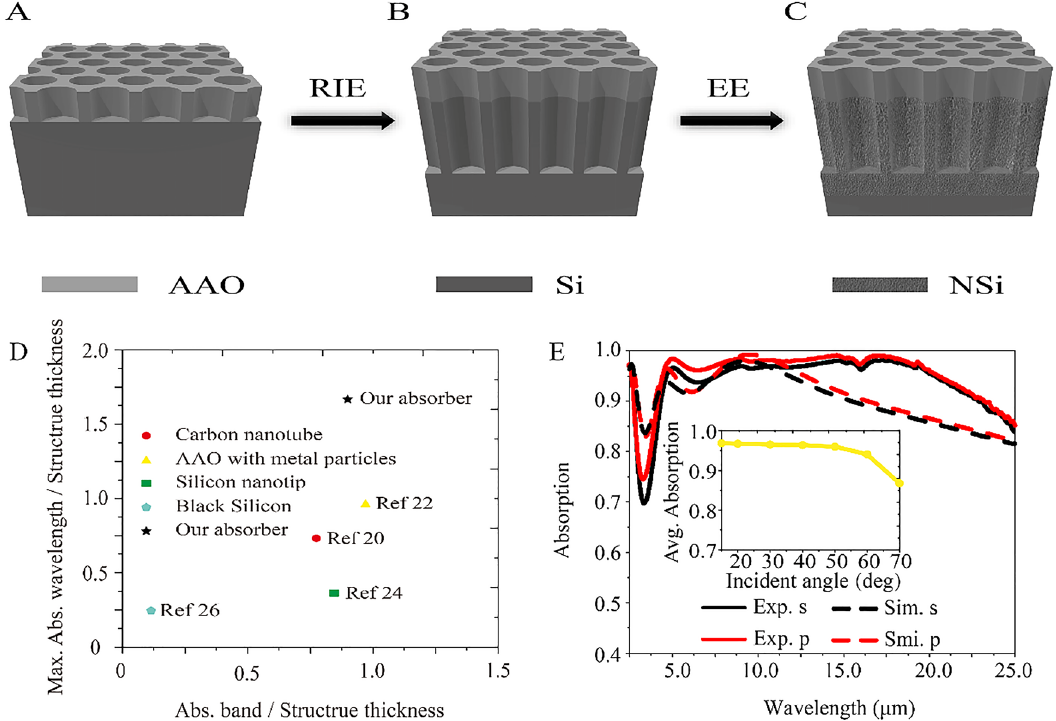
Figure 1: (A – C) Schematic of the fabrication process. (A) Si substrate covered with mesoporous honeycomb AAO layer. (B) AAO/SH/Si structure formed after RIE. (C) AAO/NSH/NSi/Si structure formed after EE. The thicknesses of AAO, NSH, and NSi were 400 nm, 1.2 μ m, and 400 nm, respectively. (D) Absorption wavelength range and maximal absorption wavelength normalized by absorption thickness for our absorber and other reported absorbers. (E) Measured (solid lines) and simulated (dashed lines) absorption spectra for the samples for s -polarized (black lines) and p -polarized (red lines) light at an incident angle of 15 ° . The inset shows the measured average absorption in the 8 – 15 μ m wavelength range as a function of incident angles.